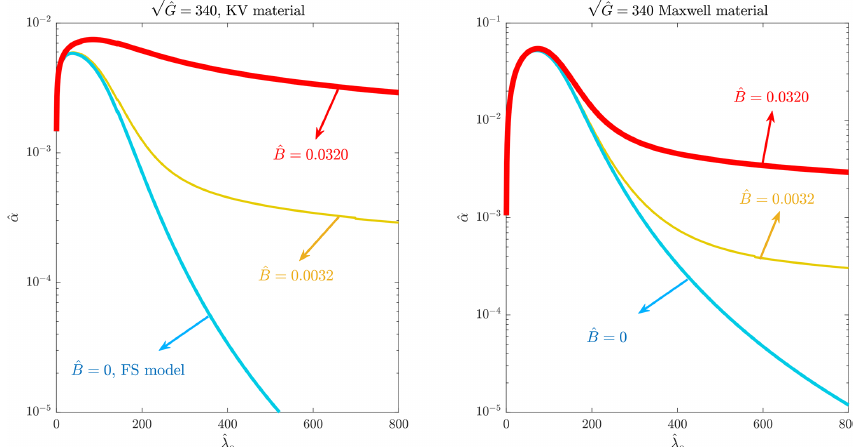
Figure 3. Effects of fluid damping coefficient on ˆ α vs. the ˆ λ o curves viscoelastic models give.